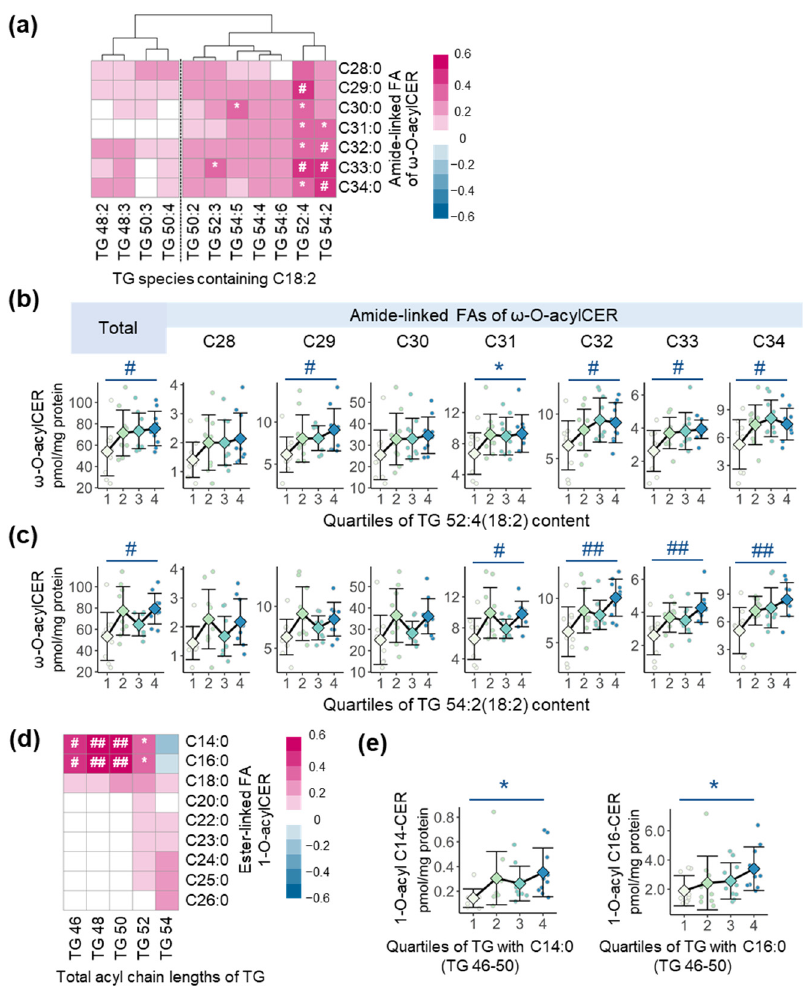
Figure 2. The association of skin surface acylceramides (acylCER) and triacylglycerols (TG). ( a ) Spearman correlation heatmap between ω‐ O ‐ acylCER (the sum of EOS and EOP) and TG species containing C18:2. Alterations in levels of ω‐ O ‐ acylCER across the quartiles of ( b ) TG 52:4(18:2) content and ( c ) TG 54:2(18:2) content (means ± standard deviations; SD). Analysis of variance (ANOVA) with contrast was conducted to calculate p for trend. ( d ) Spearman correlation heatmap between 1 ‐ O ‐ acylCER (the sum of 1 ‐ O ‐ ENS and 1 ‐ O ‐ EAS) and TG categorized by total acyl chain lengths. ( e ) Alterations in the level of 1 ‐ O ‐ acyl C14 or C16 ‐ CER across the quartiles of C46–50 TG content containing C14:0 or C16:0 (means ± SD). * p < 0.05, # adjusted p < 0.05 and ## adjusted p < 0.01; adjusted p value was calculated using the Benjamini–Hochberg (BH) method to correct multiple tests.